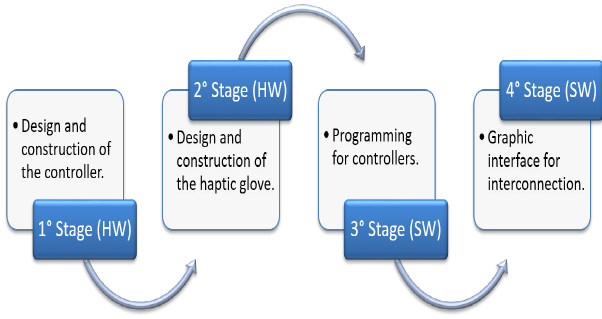
Figure 7. Diagram of the glove construction process.